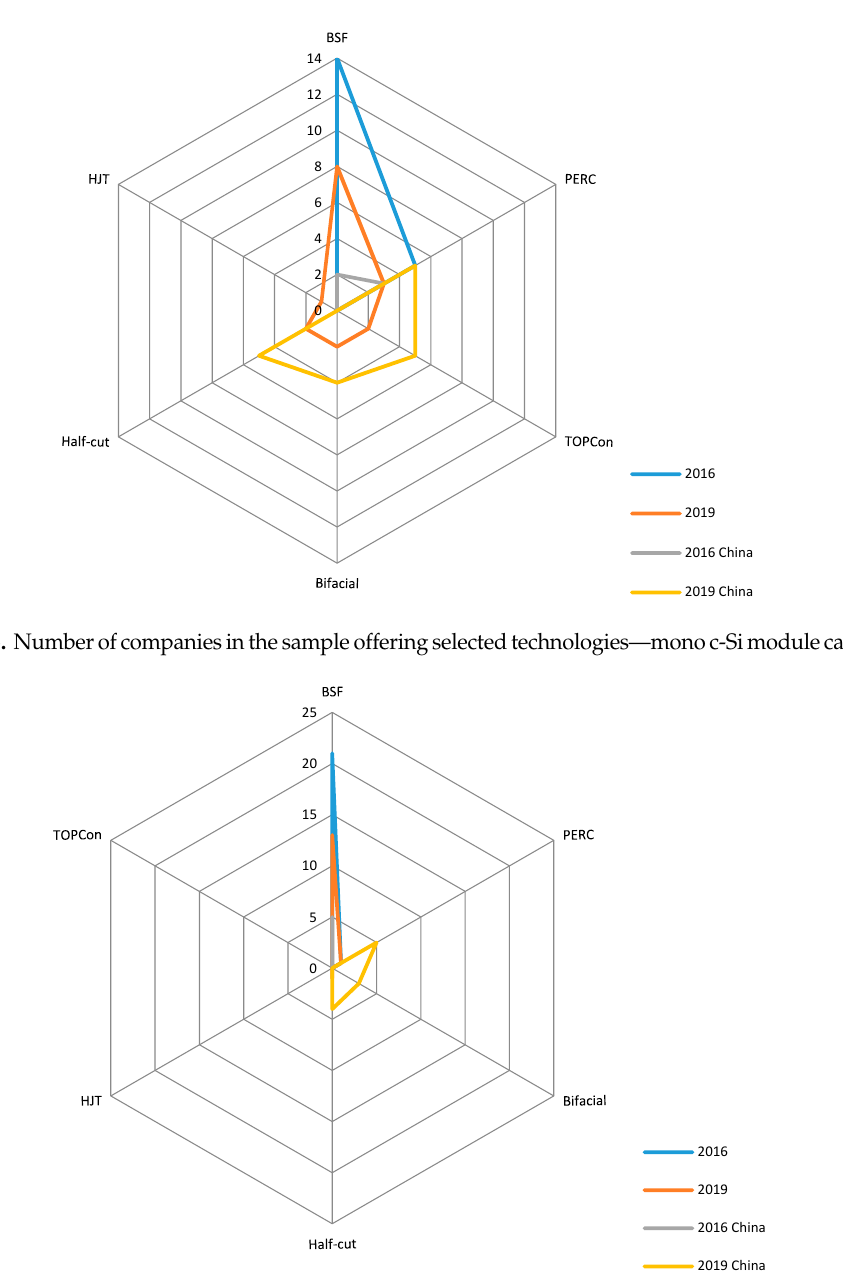
Figure 16. Number of companies in the sample offering selected technologies—poly c-Si module category.